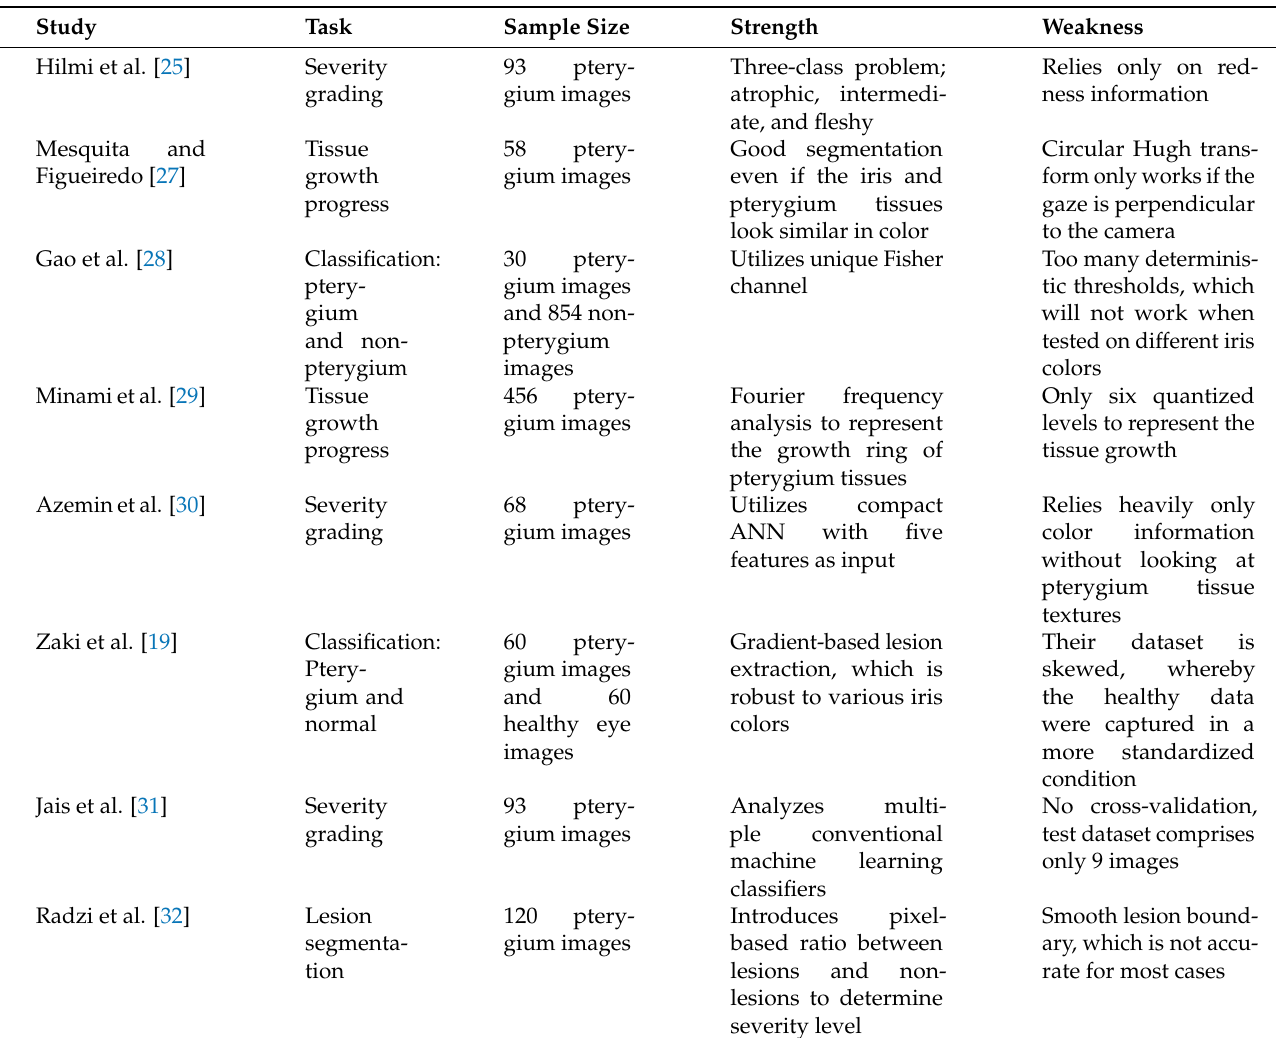
Table 3. Summary of automated pterygium screening systems using conventional